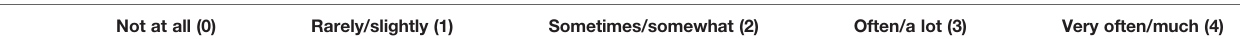
TABLE 7 | The 30-item Defense Mechanism Rating Scales Self-Report (DMRS-SR-30) questionnaire (English version). In the past week, how much did you deal with dif fi cult emotions or situations in the following ways? Not at all